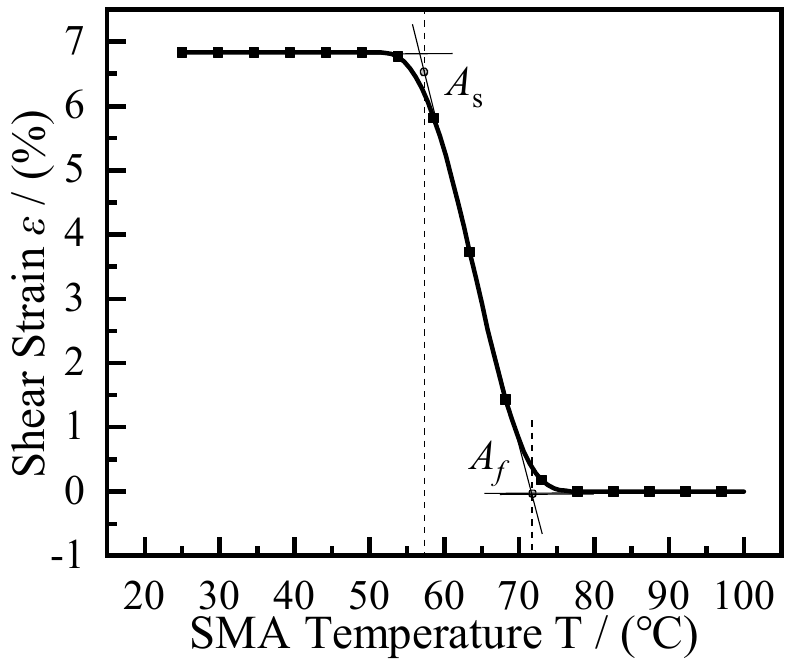
Figure 2. SMA shear strain versus temperature.